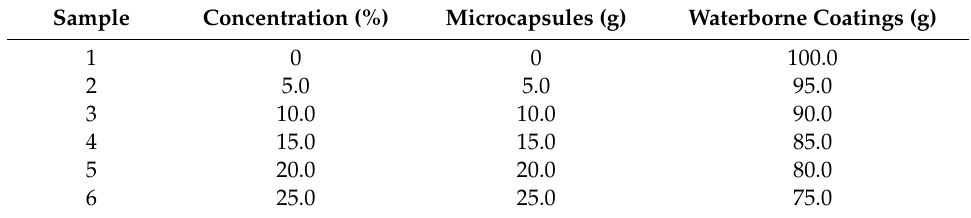
Table 2. Composition of waterborne